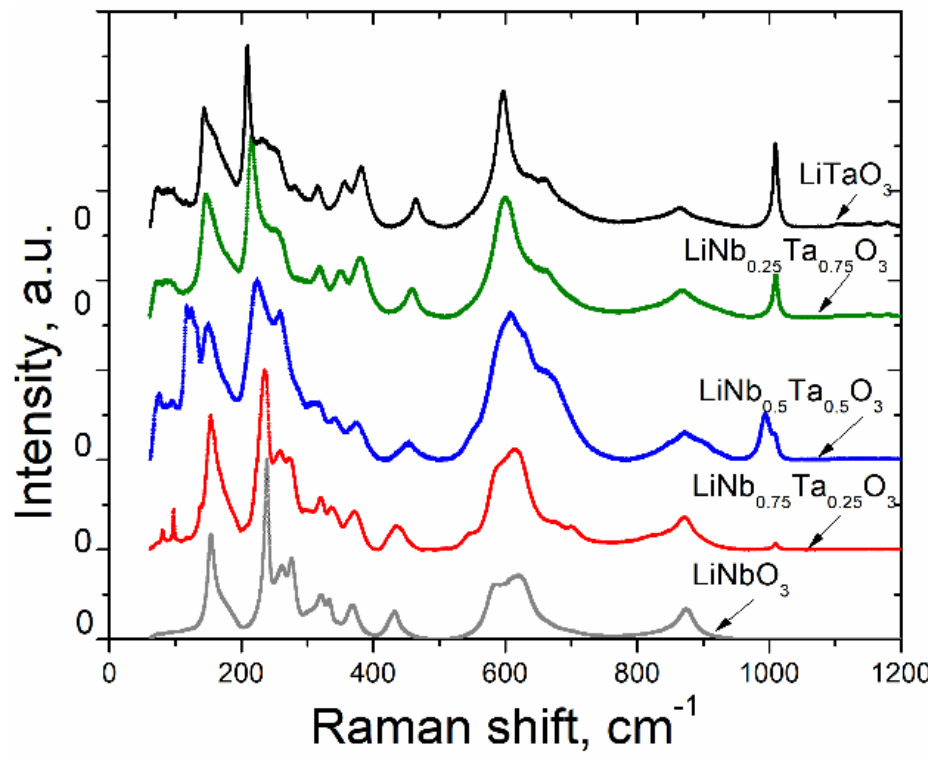
Figure 9. Raman spectra of LiNb 1 − x Ta x O 3 nanopowders obtained in non-optimal synthe- sis tions.